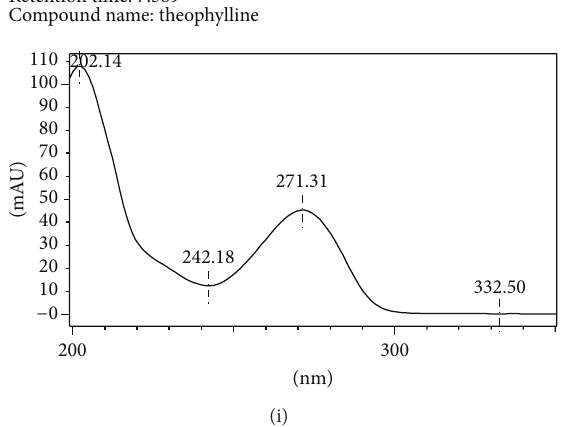
Figure 5: Typical HPLC chromatogram of (a) gemcitabine exposed to alkaline stress (1N NaOH, 60 ∘ C, 1h), (b) contour plot, (c) peak purity index, and extracted UV spectra of (d) gemcitabine, (e) degraded product d-1, (f) d-2, (g) d-4, (h) d-5, and (i) theophylline.